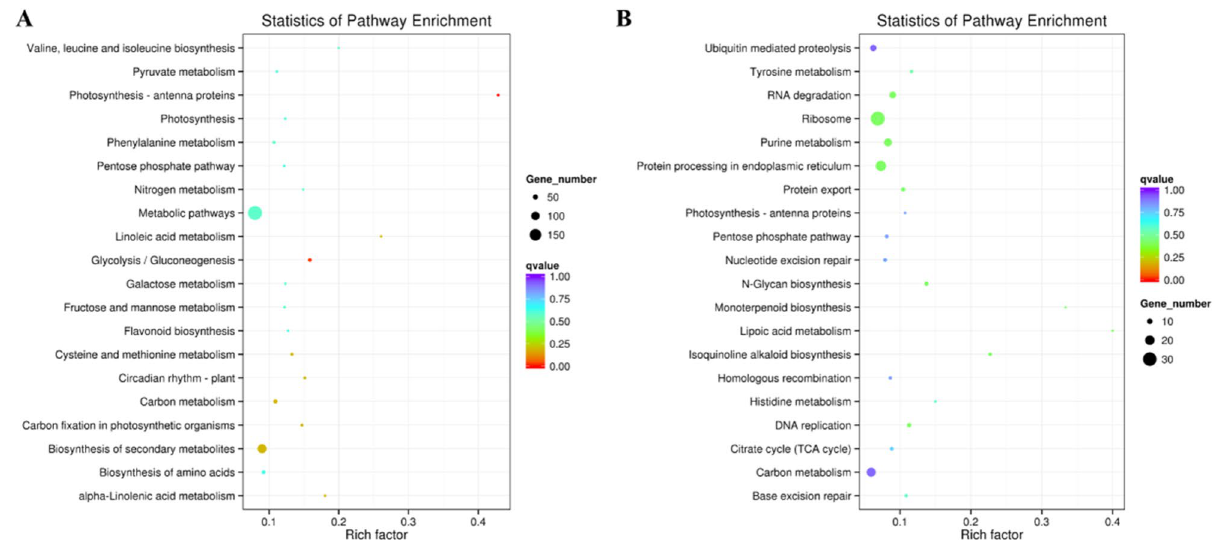
Figure 5. Statistics results of pathway enrichment of DEGs ( A ) and DETs ( B ). DEG: differentially expressed gene; DET: predicted target gene of the differentially expressed lncRNA. The color and the size of the circle represents the q-value and the number of DEGs or DETs enriched in the pathway, respectively. The rich factor represents the ratio between the number of enriched DEGs or DETs in a pathway and the number of annotated genes, the higher the rich factor is, the higher degree of